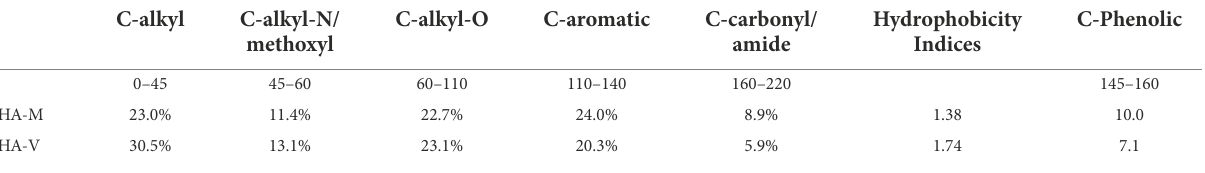
TABLE 2 Distribution of different types of carbons, relative areas of spectral regions and the degree of aromaticity in humic